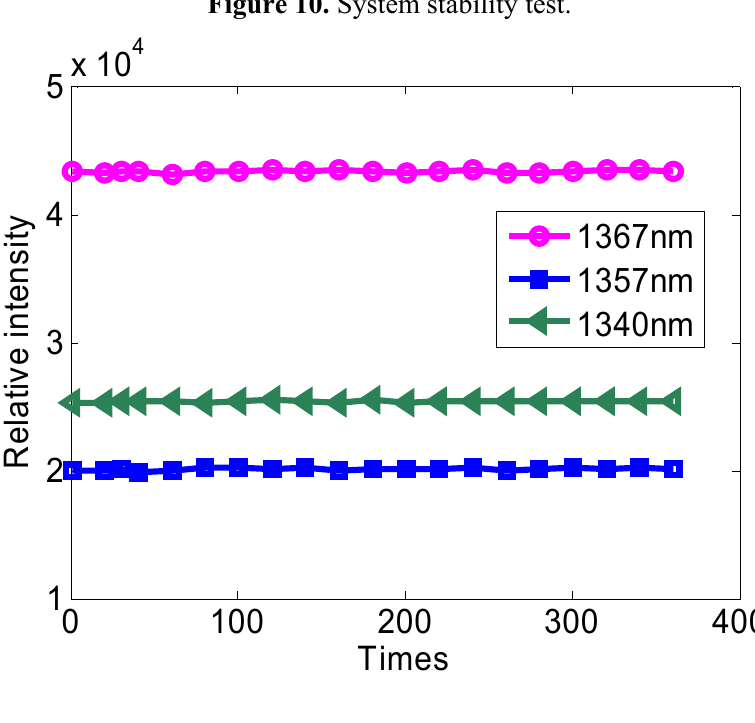
Figure 10. System stability